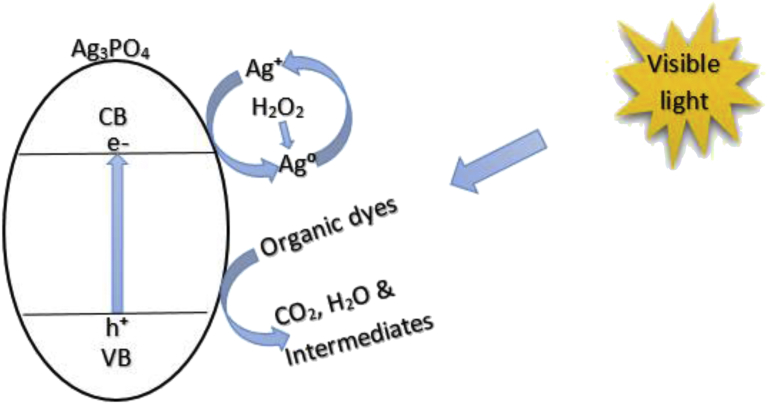
A schematic for mechanism of photocatalysis of Ag3PO4.